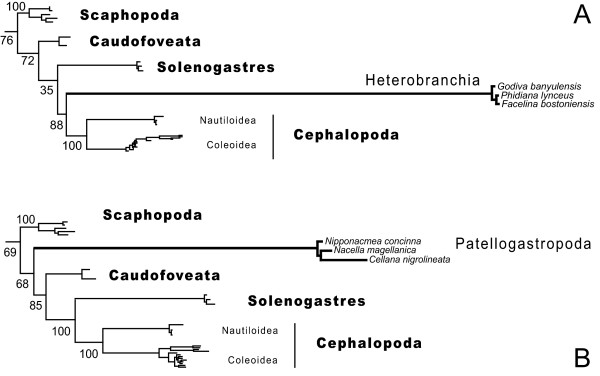
ML analyses with a modified taxon sampling. A: The heterobranchs are here represented by representatives of the fast evolving Aeolidina, only. All other taxa are identical to the sampling shown in figure 3, but we excluded also Patellogastropoda. B: Same alignment as used in the inference for figure 3 but excluding all other gastropods except Patellogastropoda. Both analyses were conducted on ten different starting trees with a partitioned GTR + and S16 substitution model and enabling the bootstopping criterium in RAxML (-# autoFC).